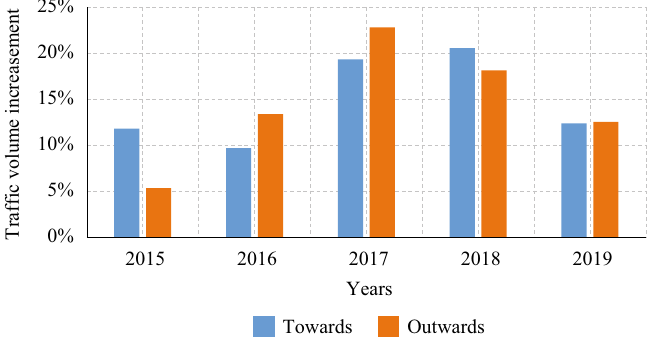
Figure 1. Traffic volume increase towards and outward Klaipėda during the